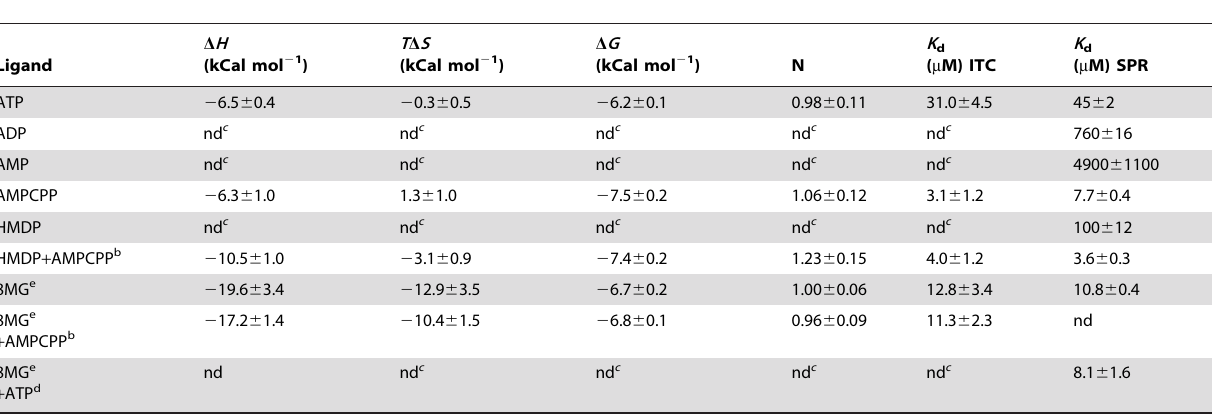
Table 1. Thermodynamic and kinetic parameters for the binding of ligands to SaHPPK, as determined by ITC a and SPR a .